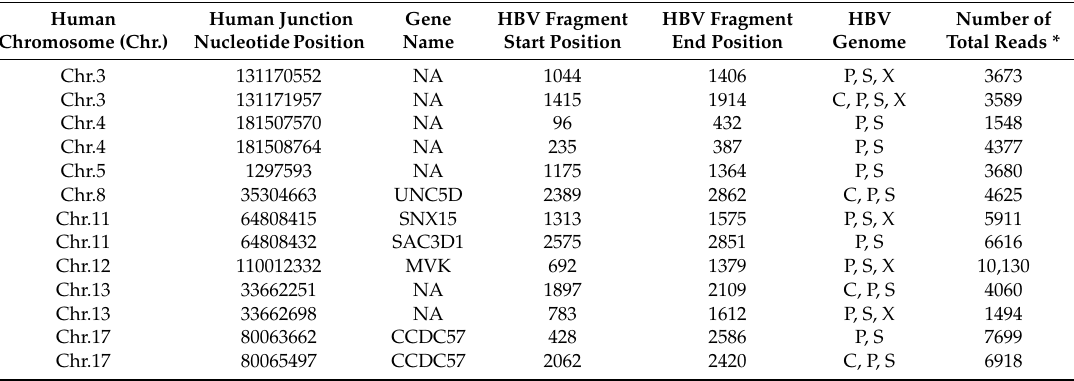
Table 2. HBV and human genomes in PLC/PRF/5 cells determined by HBV sequence capture-based next-generation sequencing.